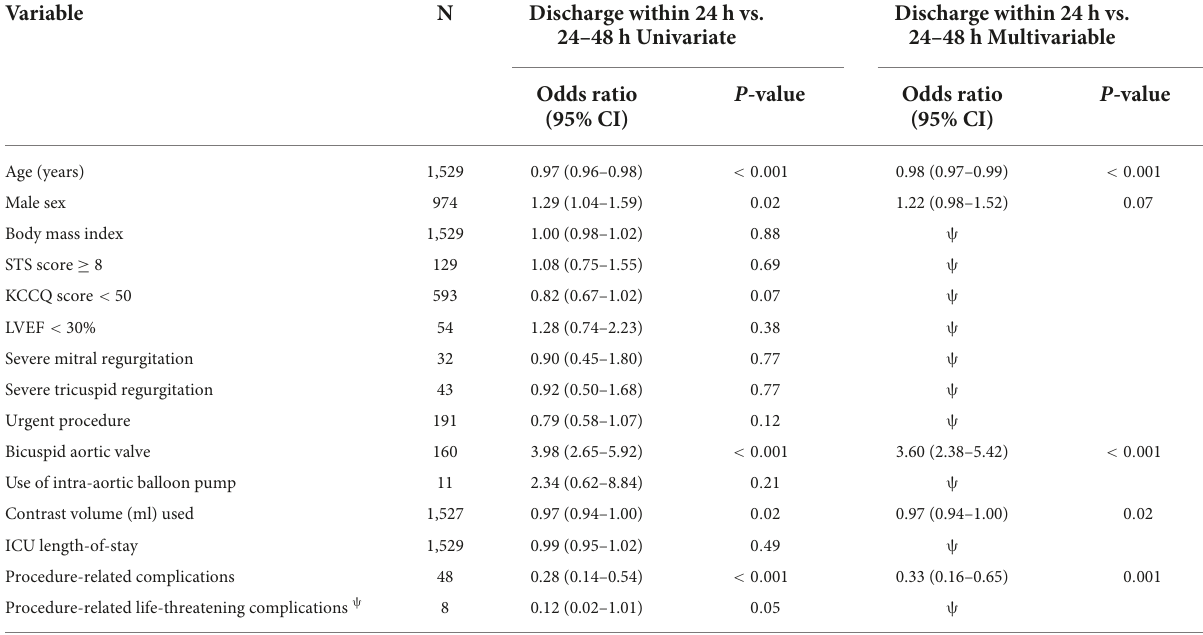
TABLE 3 Univariate and multivariable analyses of discharge within 24 h (vs. 24–48 h).